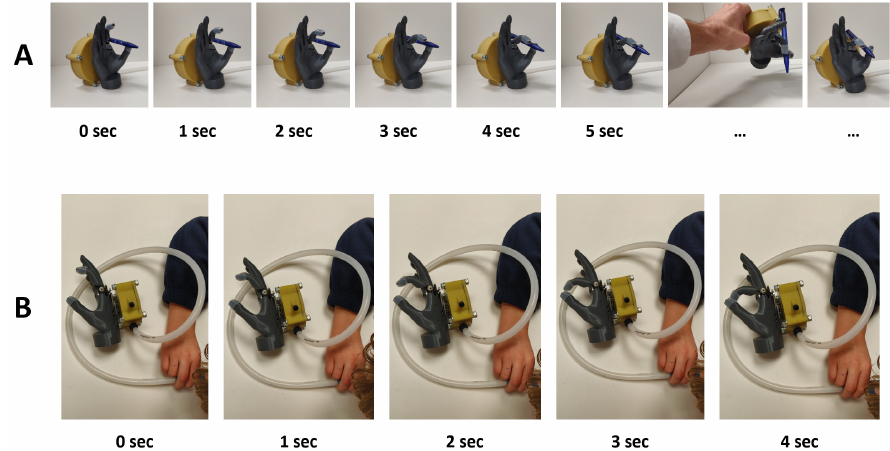
Figure 6. Demonstration model of breathing-powered prosthetic device. ( A ) Demonstration of the dynamic tip grip function with a pen. ( B ) Demonstration of the breathing-powered closing of the terminal device by a nine year-old